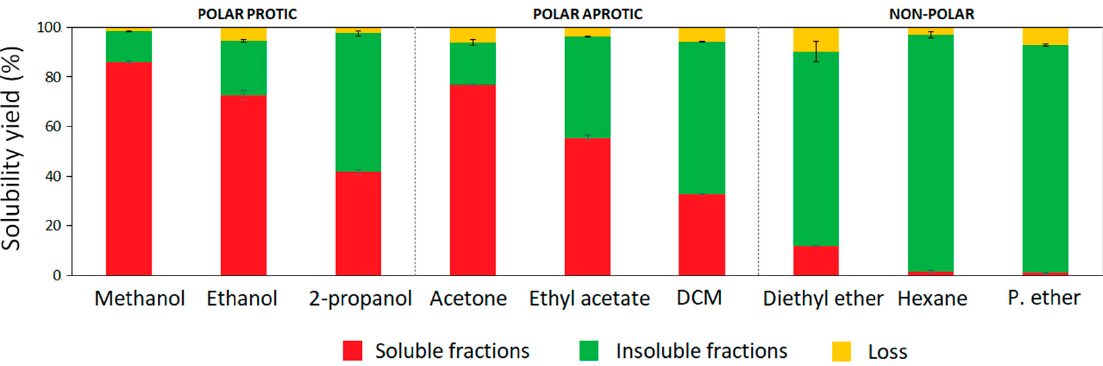
Figure 1. Yields of soluble and insoluble lignin fractions from one-step extraction processes. The molecular features of soluble and insoluble fractions were examined through gel permeation chromatography, analytical pyrolysis, and infrared spectroscopy, with the aim of evaluating the differences and similarities of fractionated lignins, and of studying the effectiveness of the organic solvents to obtain diverse types of lignins from the crude industrial kraft lignin. The average molecular weight and polydispersity indexes of both soluble and insoluble fractions are presented in Table 1. Table 1. Molecular weight-average (Mw), number-average (Mn) and polydispersity (PDI) of HKL and isolated lignin fractions. Soluble Fractions Insoluble